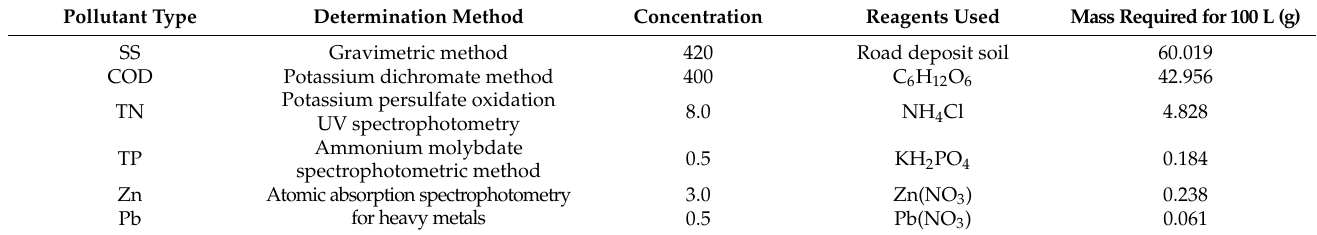
Table 4. Detection of rainwater runoff pollutants and the corresponding reagent